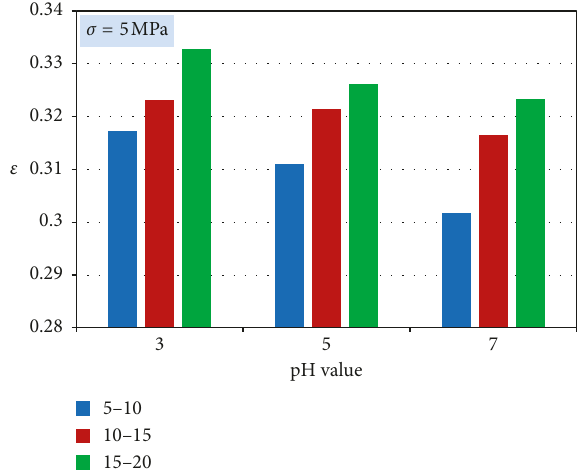
Figure 6: Strain value of coal gangue samples with different particle sizes when subjected to 5MPa of